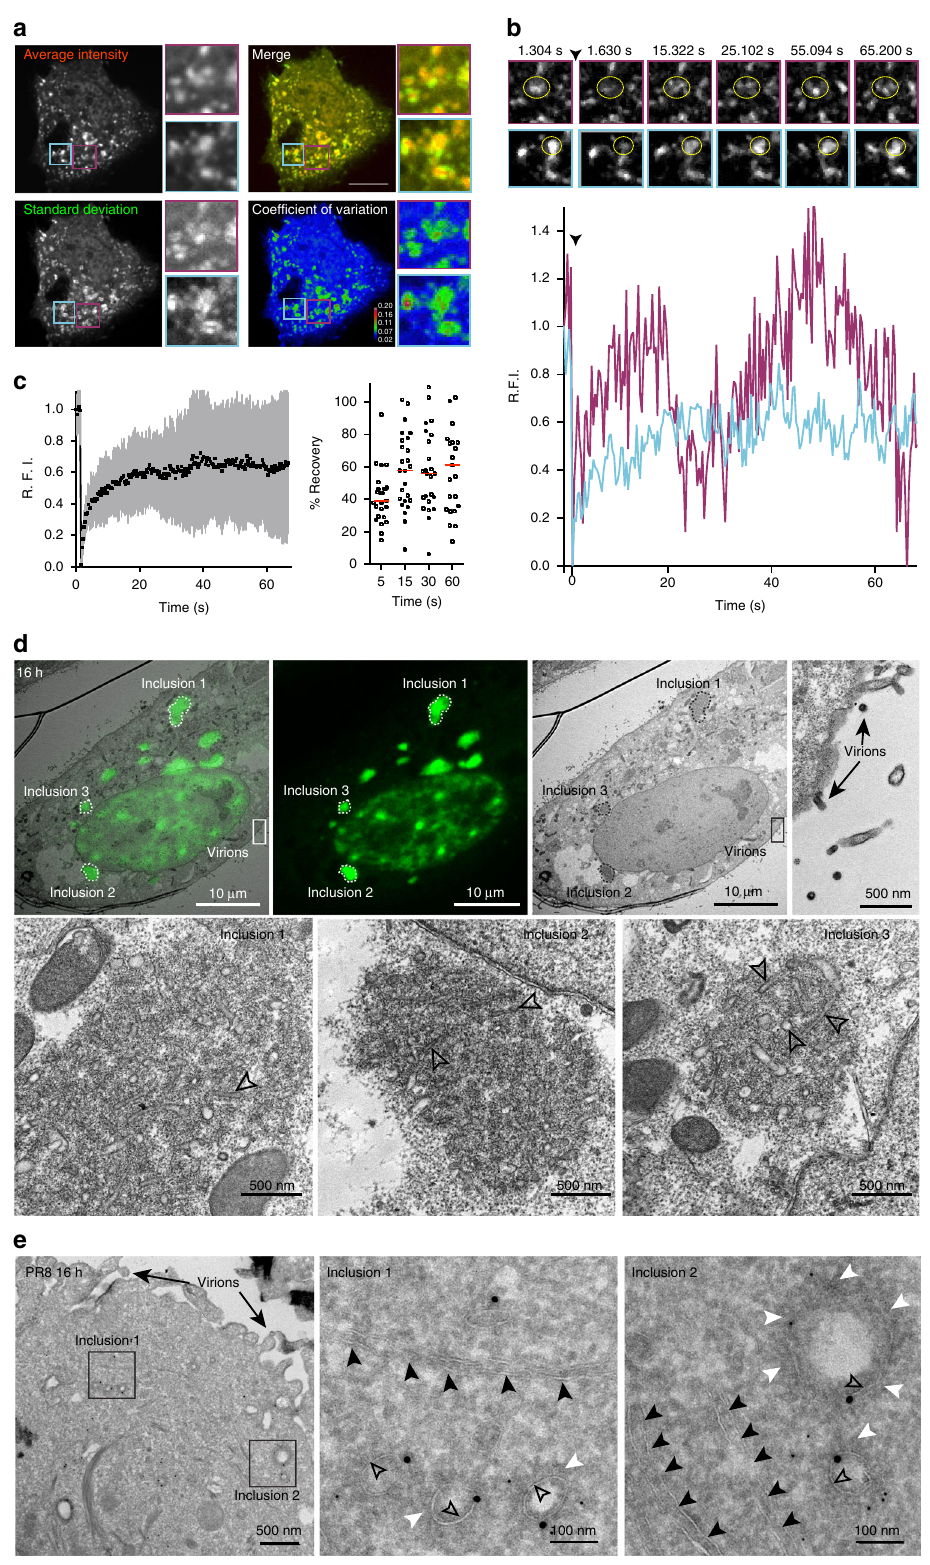
RNA mimic polyinosinic:polycytidylic acid [poly(I:C)]. Results show that there are no differences between both cell lines, in any of the conditions analyzed (Fig. 8c). Also, NS1 mutant virus induced higher mRNA levels than the WT virus, con fi rming the IFN-antagonizing role of NS1 (Fig. 8c). At the protein level, cell